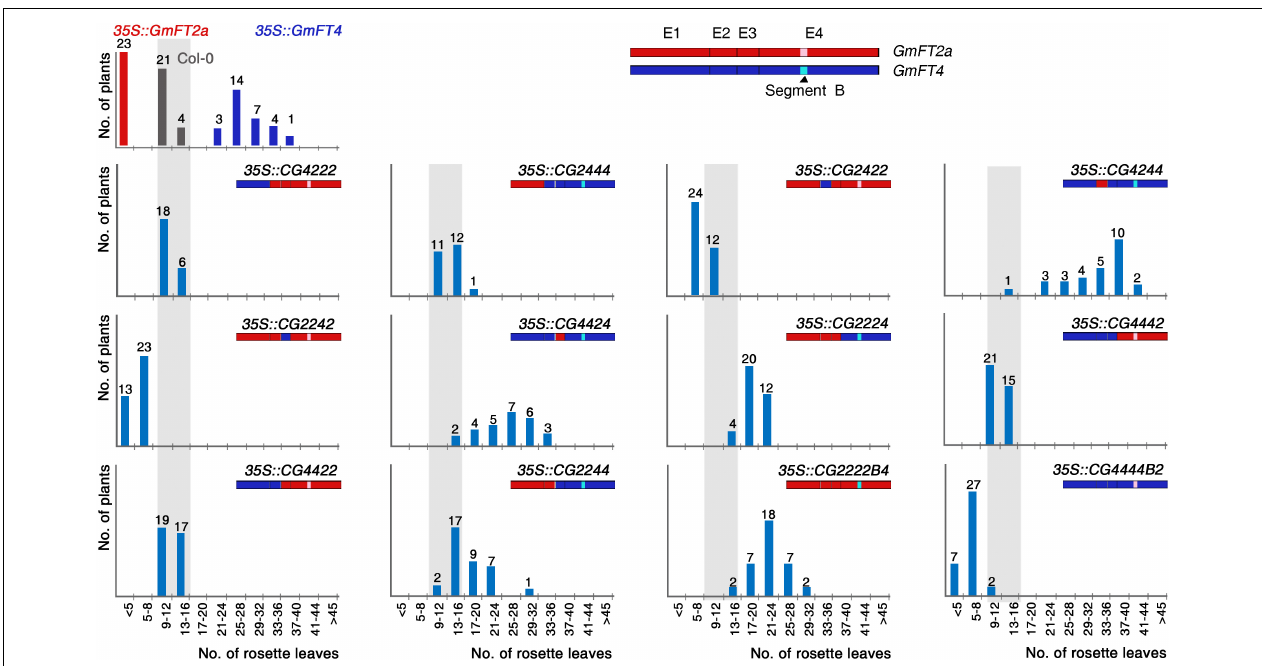
FIGURE 5 | Flowering times of transgenic Arabidopsis plants expressing GmFT2a/GmFT4 exon swapping chimeras. The exons of GmFT2a and GmFT4 are shown as red and blue boxes, respectively. Segment B regions of GmFT2a and GmFT4 are highlighted by pink and cyan colors, respectively. The distribution of flowering times in LD conditions for T1 transformants and control plants (Col-0) are indicated by vertical bars; gray, red, dark blue, and light blue bars for Col-0, 35S::GmFT2a, 35S::GmFT4, and the chimeras, respectively. The number of plants is indicated above each